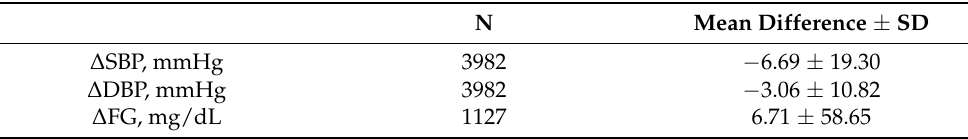
Table 2. Chlorthalidone blood pressure and glucose response 1 .